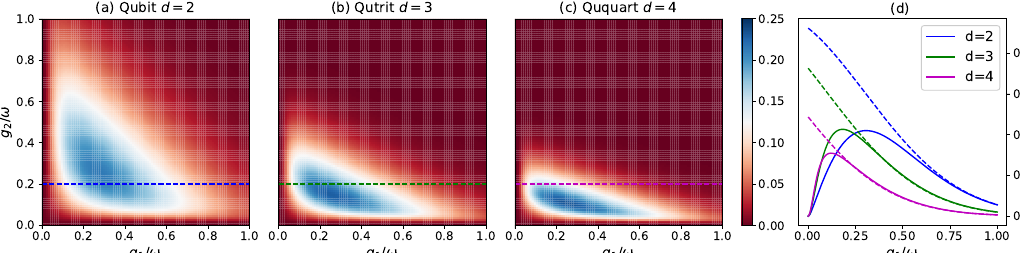
Figure 4: Coupling dependence of the ground state negativity between the qubit and the qudit. (a)-(c) Density plots of the ground state negativity as a function of g and g for the (a) qubit-qubit, (b) qubit-qutrit, (c) qubit-ququart cases. The plots 2 are obtained by numerical calculations for Ω = 0.2 ω , indicated by the dashed lines in panels (a)-(c). The results plots for g 2 obtained through numerical calculations (solid) are compared with the approximate expression of the negativity Eq. (16) (dashed), obtained in the ultrastrong coupling